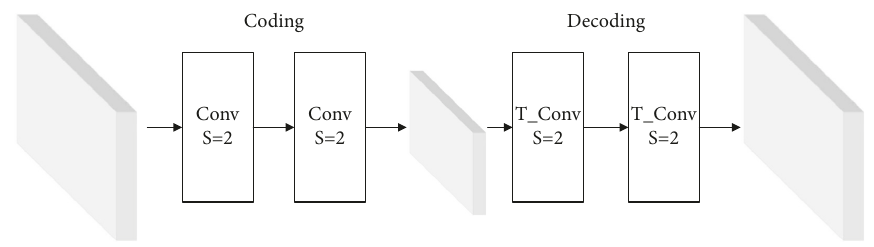
Figure 3: Semantic segmentation module